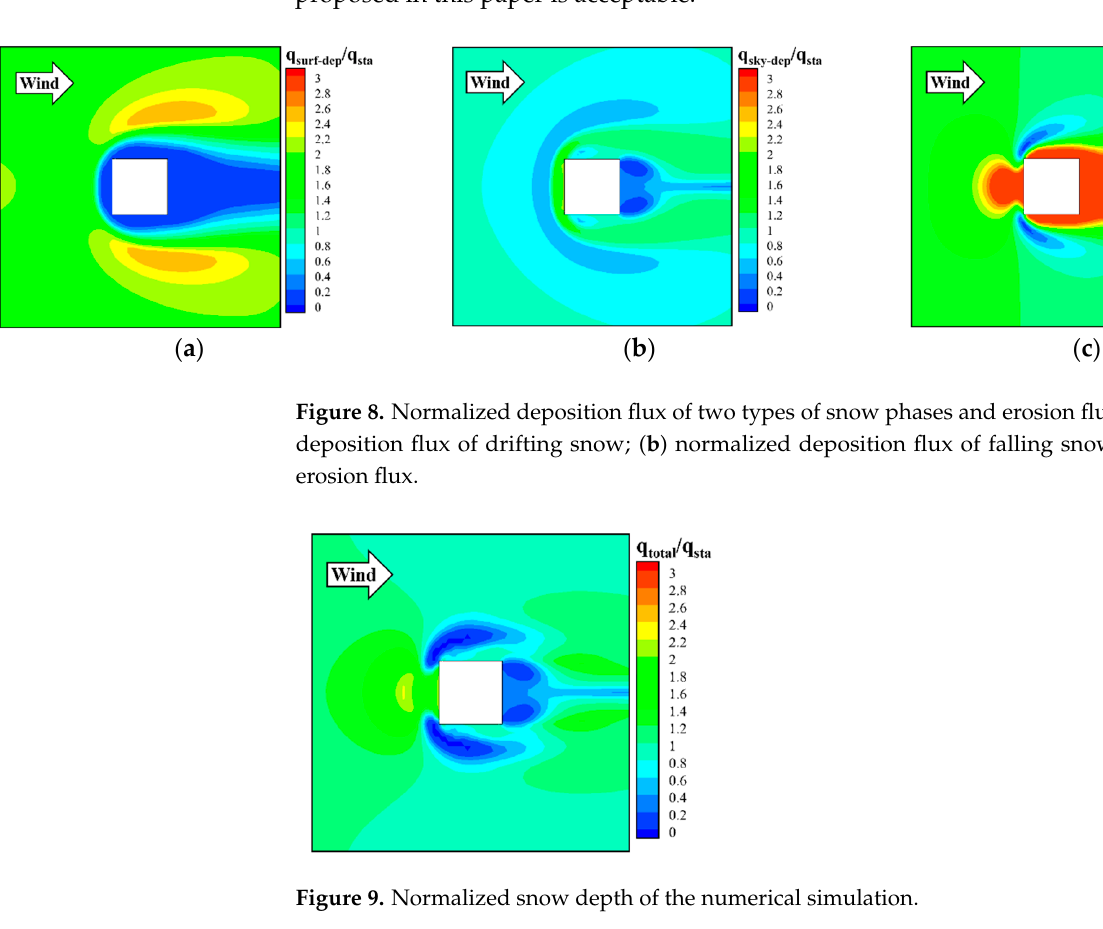
Figure 8. Normalized deposition flux of two types of snow phases and erosion flux: ( a ) normalized deposition flux of drifting snow; ( b ) normalized deposition flux of falling snow; ( c ) normalized